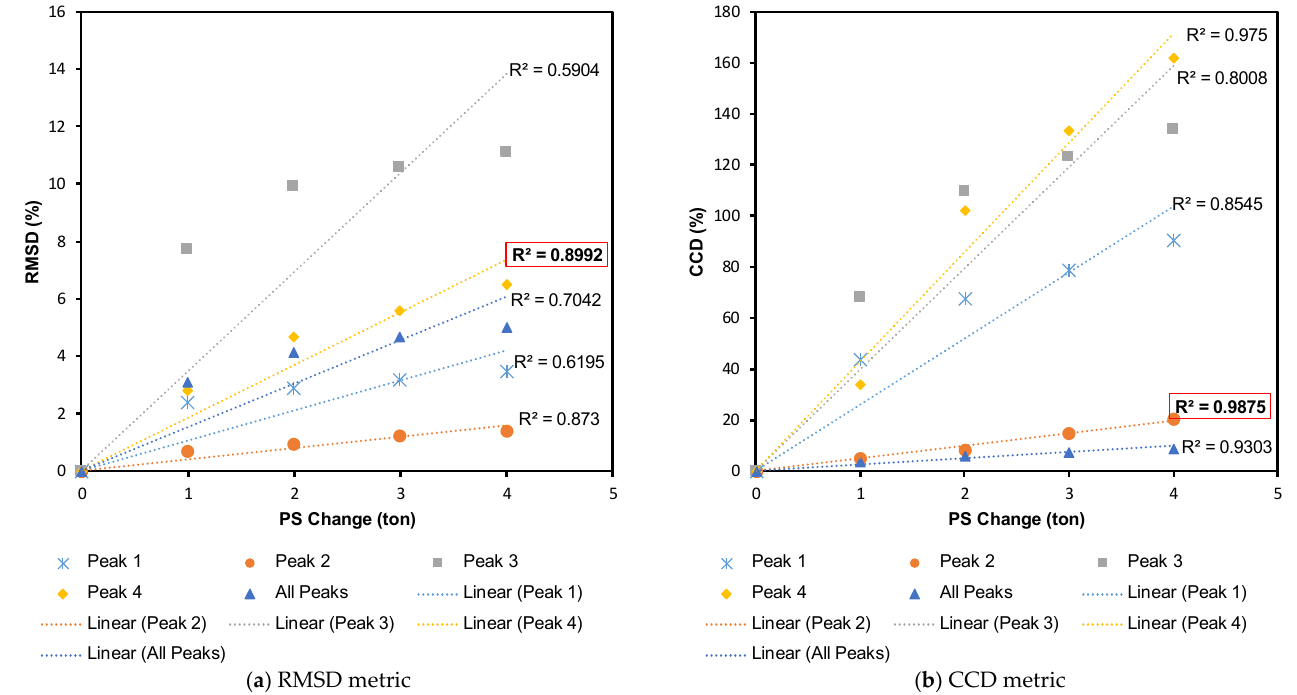
Figure 11. Linear regression analyses of EMI features.